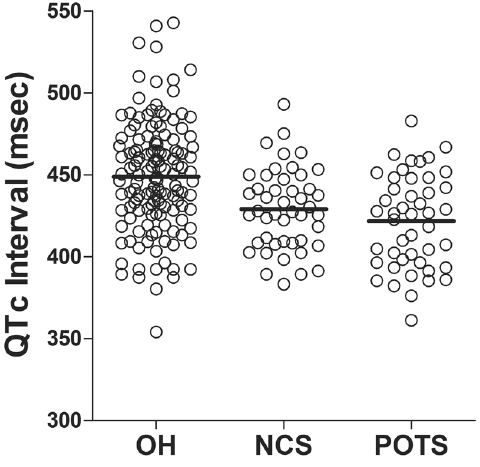
Figure 1. Findings of the corrected QT interval. Patients with orthostatic hypotension (OH) had a more prolonged corrected QT (QTc) interval (448.8 6 33.6 msec) than patients with neurocardiogenic synco- pe (NCS) (429.1 6 24.6 msec, p = 0.001) and postural orthostatic tachycardia syndrome (POTS) (421.7 6 28.6 msec, p , 0.001). No differ- ence in QTc interval was observed between NCS and POTS patients ( p =0.766).